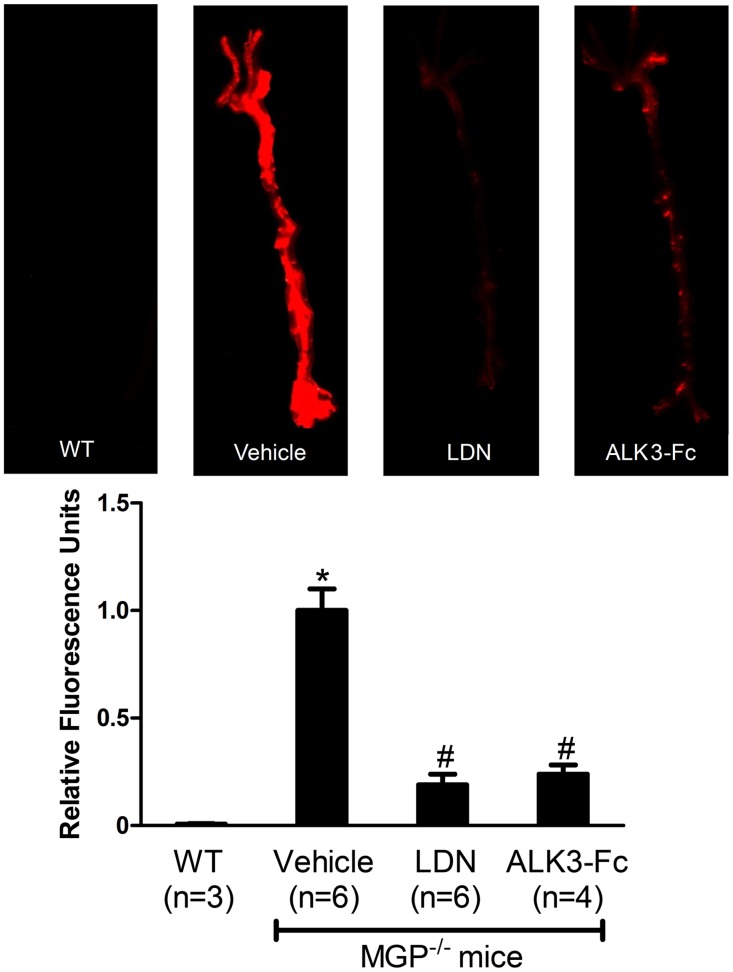
Pharmacologic inhibition of BMP signaling reduces osteogenic activity in the aortas of MGP-deficient mice.MGP-/- mice were treated with vehicle, LDN-193189 (LDN), or ALK3-Fc starting at day 1 of life for 28 days. Wild-type mice (WT) were treated with vehicle. On day 27, OsteoSense-680 was injected via the tail vein. Aortas were harvested 24 hours later and imaged with near-infrared fluorescence (upper panel). Fluorescence intensities of the entire aorta normalized to vehicle-treated MGP-/- mouse aortas were quantified (lower panel). Inhibition of BMP signaling reduced vascular calcification by 80% in MGP-/- mice. * P<0.001 compared to vehicle-treated WT mice. # P<0.001 compared to vehicle-treated MGP-/- mice.